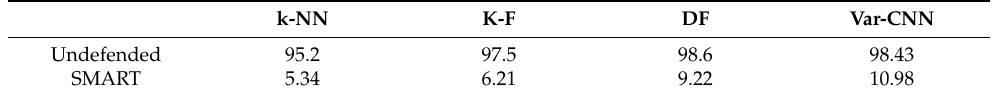
Table 4. Classification results before and after using